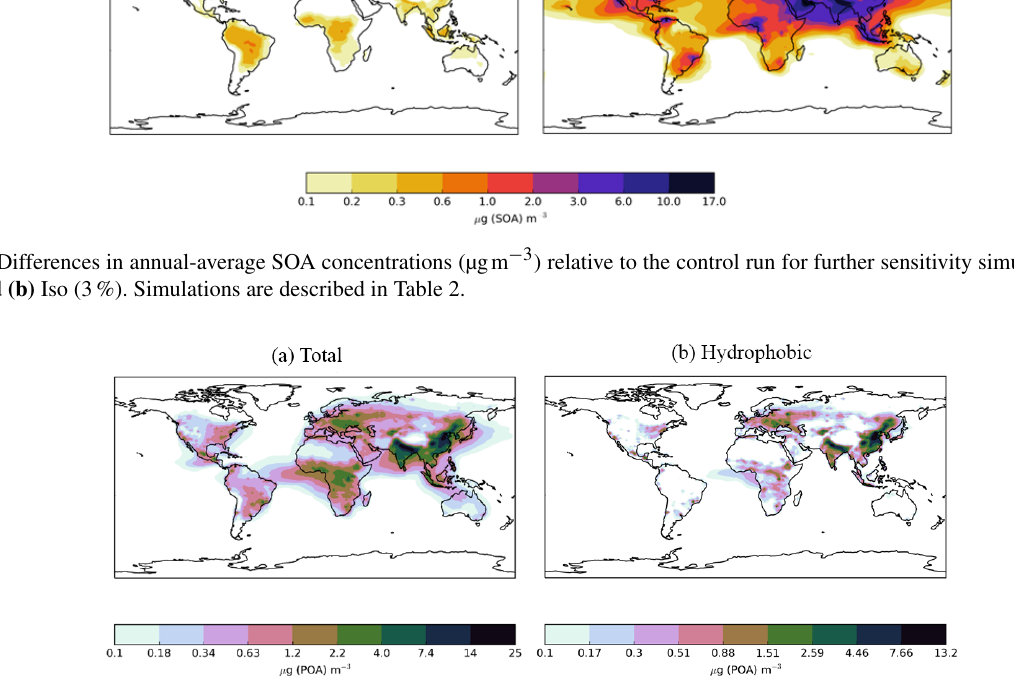
Figure 8. Annual-average surface (a) total (hydrophilic and hydrophobic) and (b) hydrophobic only, POA concentrations (µgm − 3 ) for the Control simulation. Within UKCA, all POA is emitted into the hydrophobic modes and re-distributed into the hydrophilic modes through